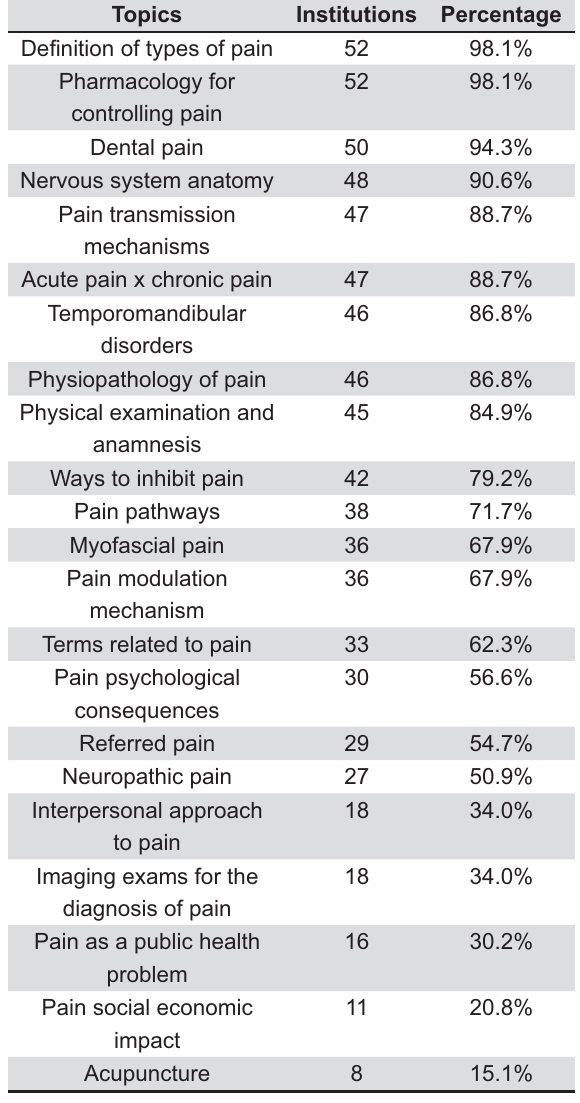
Table 3- Pain topics addressed in the